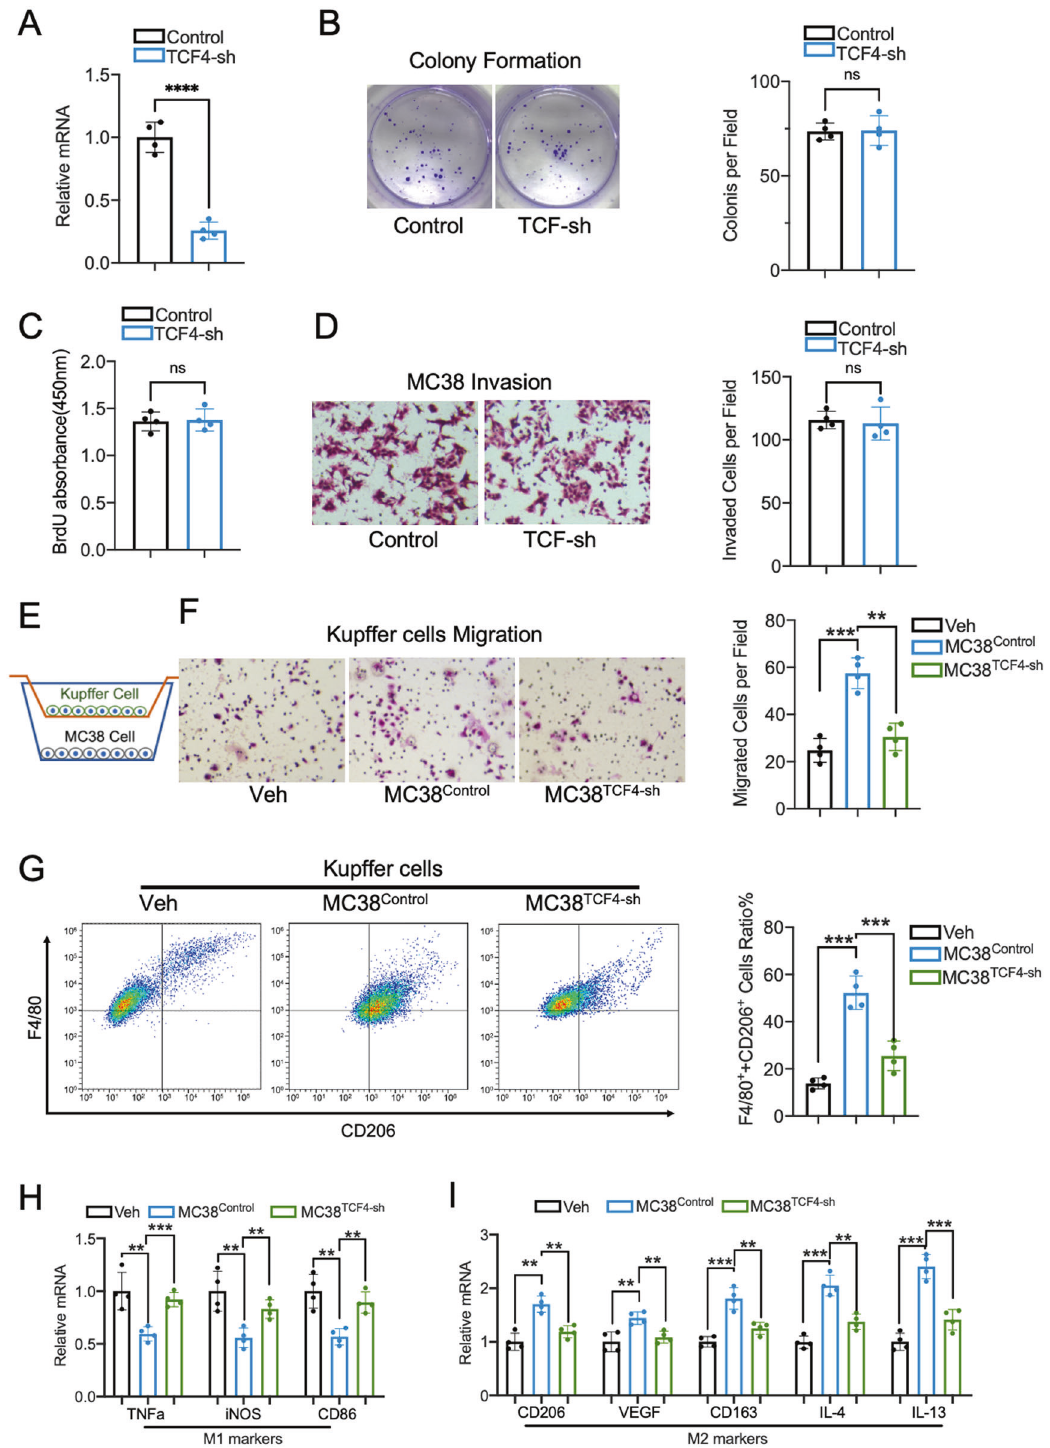
Fig. 3 TCF4 is required for the MC38 cells induced Kupffer cell migration and M2 polarization. A TCF4 mRNA expression was evaluated in MC38 cells with TCF4-shRNA stable transfection. B Representative images and quanti fi cation of colony numbers in MC38Control and MC38TCF4-sh cells. n = 4 per group. C BrdU incorporation assay of MC38 cells. D Representative Images and quanti fi cation of Matrigel- transwell invasion assay using MC38Control and MC38TCF4-sh cells. n = 4 per group; fi ve fi elds were counted per sample. E Schematic diagram of the Kupffer cell and MC38 cell coculture system. F Transwell migration assay of Kupffer cells cocultured with indicated MC38 cells or control. n = 4 per group; fi ve fi elds were counted per sample. G FACS analysis for F4/80 and CD206 of Kupffer cells co-cultured with indicated cells or control. Quanti fi cation of F4/80 + CD206 + cell ratio. n = 4 per group. H Quantitative PCR results of M1 macrophage markers expression in Kupffer cells. I M2 macrophage markers mRNA expression in Kupffer cells cocultured with MC38 cells. Data are means ± SEM. * P < 0.05, ** P < 0.01, *** P < 0.005, **** P <